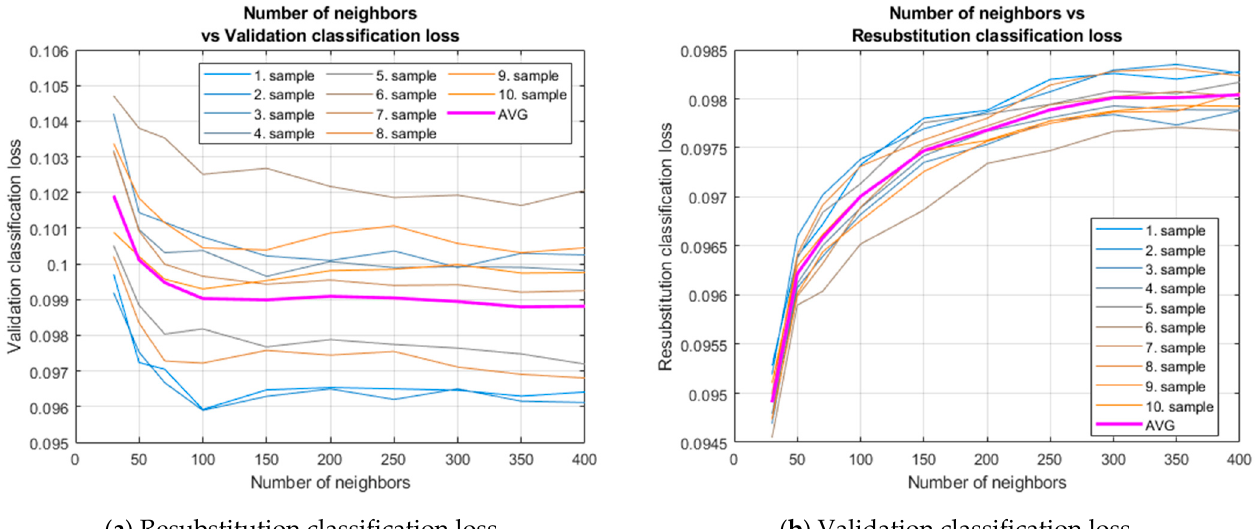
Figure 4. Summary of iteration of the number of neighbours versus the classification losses in the CART element.